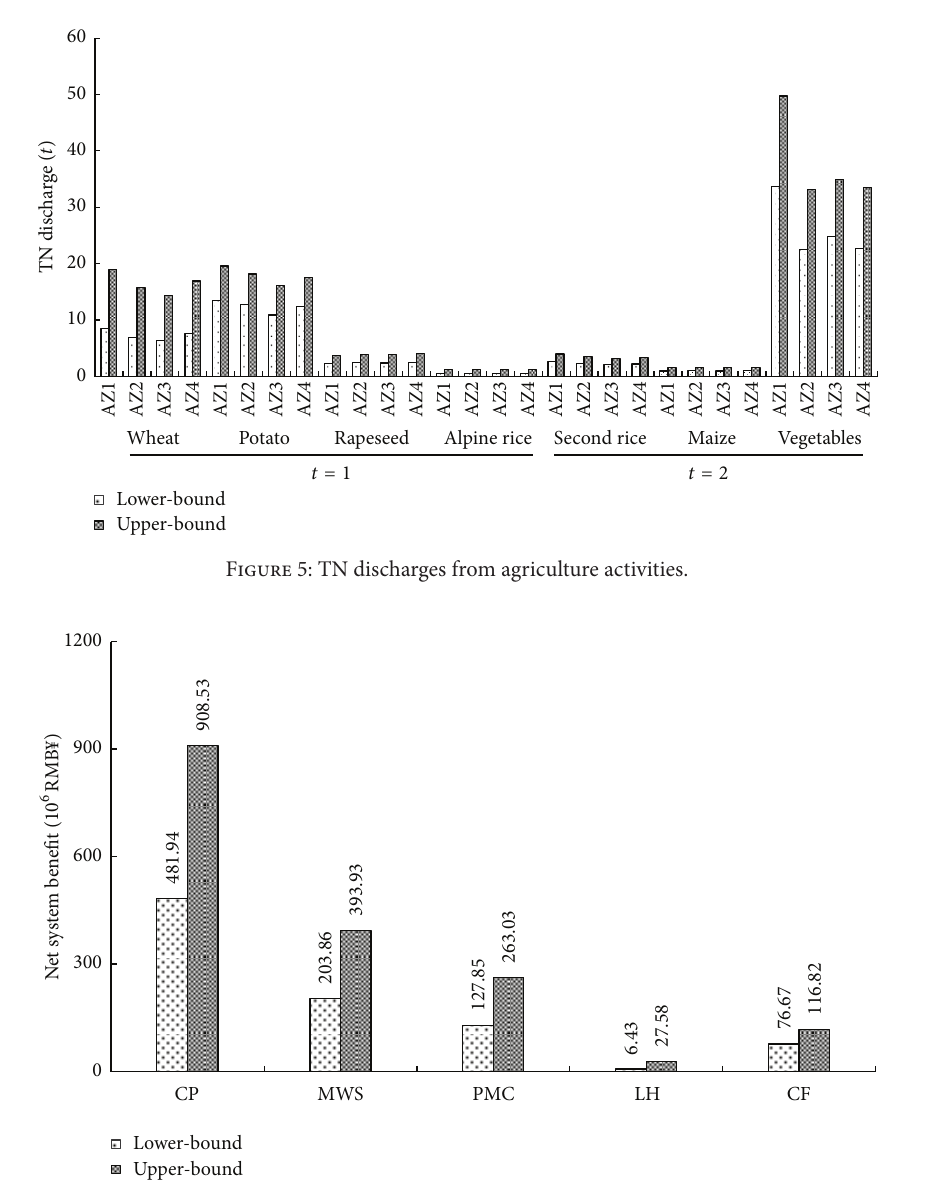
Figure 6: Net benefits from industrial and agricultural activities. Note: CP: chemical plant; MWS: municipal water supply; PMC: phosphorus mining company; CF: crop farming; LH: livestock